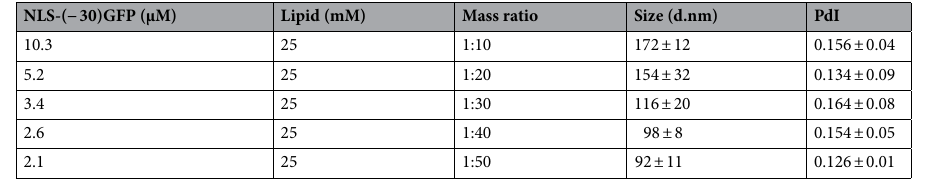
Table 1. Physicochemical characterization of NLS-(− 30)GFP-LNP by mixing NLS-(− 30)GFP with lipids at various mass ratios. The lipid mixture was composed of DOP-DEDA, DPPC, and cholesterol at a 45:10:45 molar ratio, and 1 mol% DMG-PEG5k was added. The mass ratios denote NLS-(− 30)GFP-LNP/total lipids (w/w). PdI = polydispersity index. Results are presented as the mean ± standard deviation (SD) of more than three independent